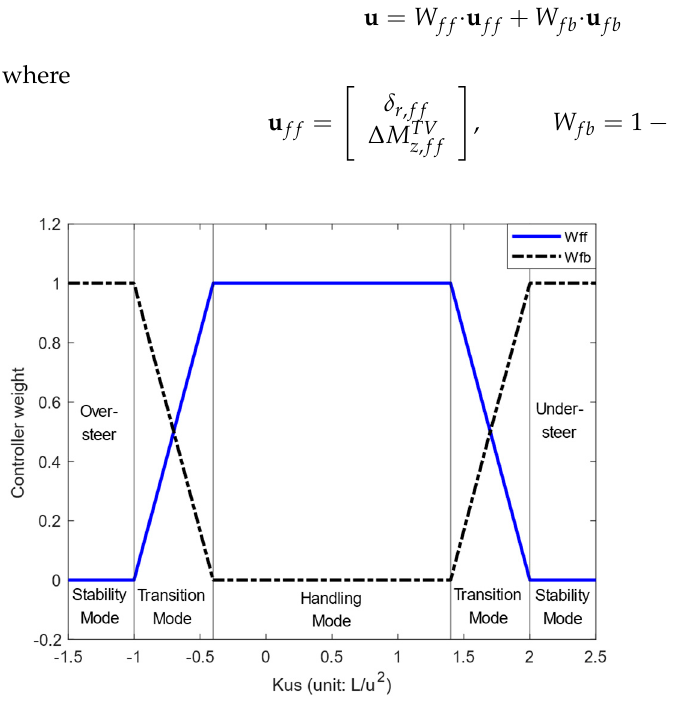
Figure 9. Weighting between the feedforward and feedback controllers.